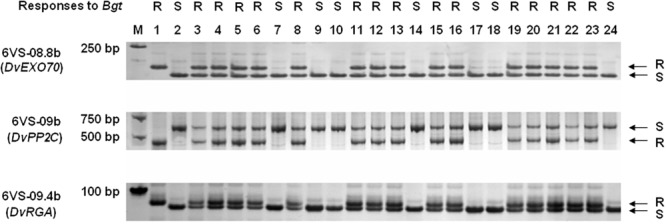
PCR amplification patterns of the co-segregated markers 6VS-08.8b, 6VS-09b, and 6VS-09.4b, corresponding to the genes DvEXO70, DvPP2C, and DvRGA, respectively. 1: the resistant parent DvRes-1; 2: the susceptible parent DvSus-1; 3–24: different recombinants. Powdery mildew responses were showed above the corresponding parents and recombinants. The arrows indicate the DNA bands that were same to the resistant (R) or susceptible (S) parents.